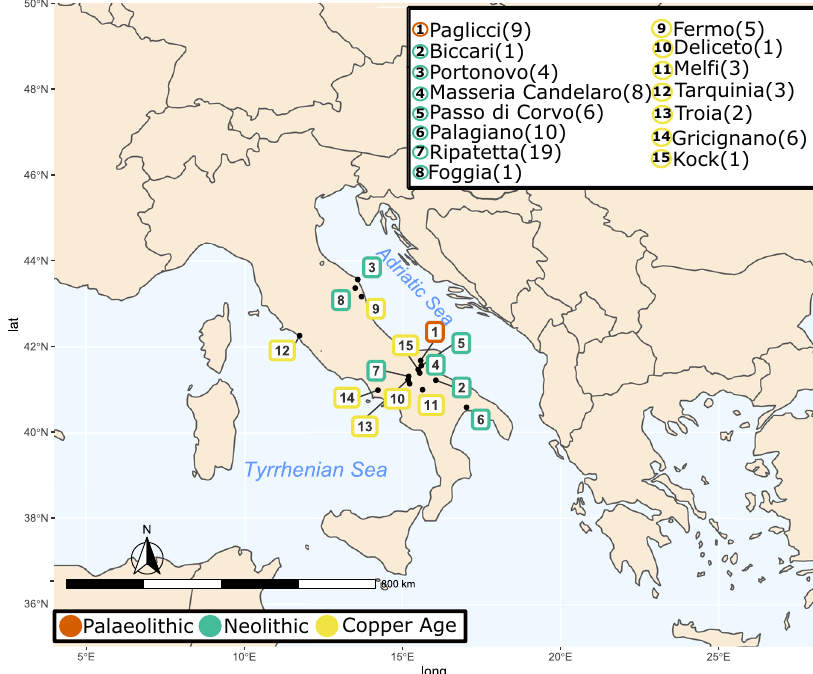
Fig. 1 | Samples distribution. Sampled archaeological site distribution across the Central-South Italian peninsula. The number of samples per site are presented in